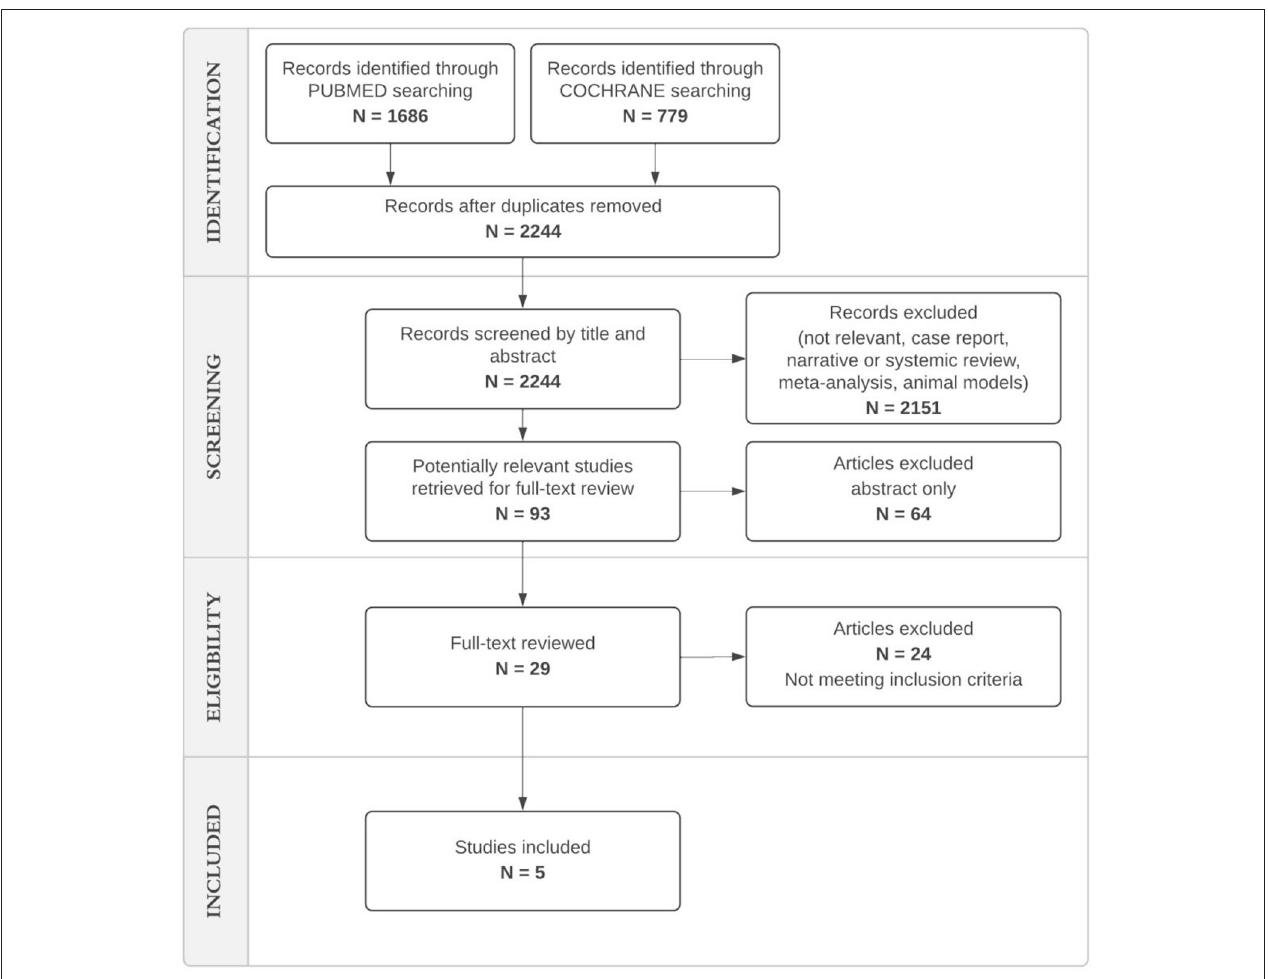
FIGURE 1 | Flow chart: identification of studies via Pubmed and Cochrane